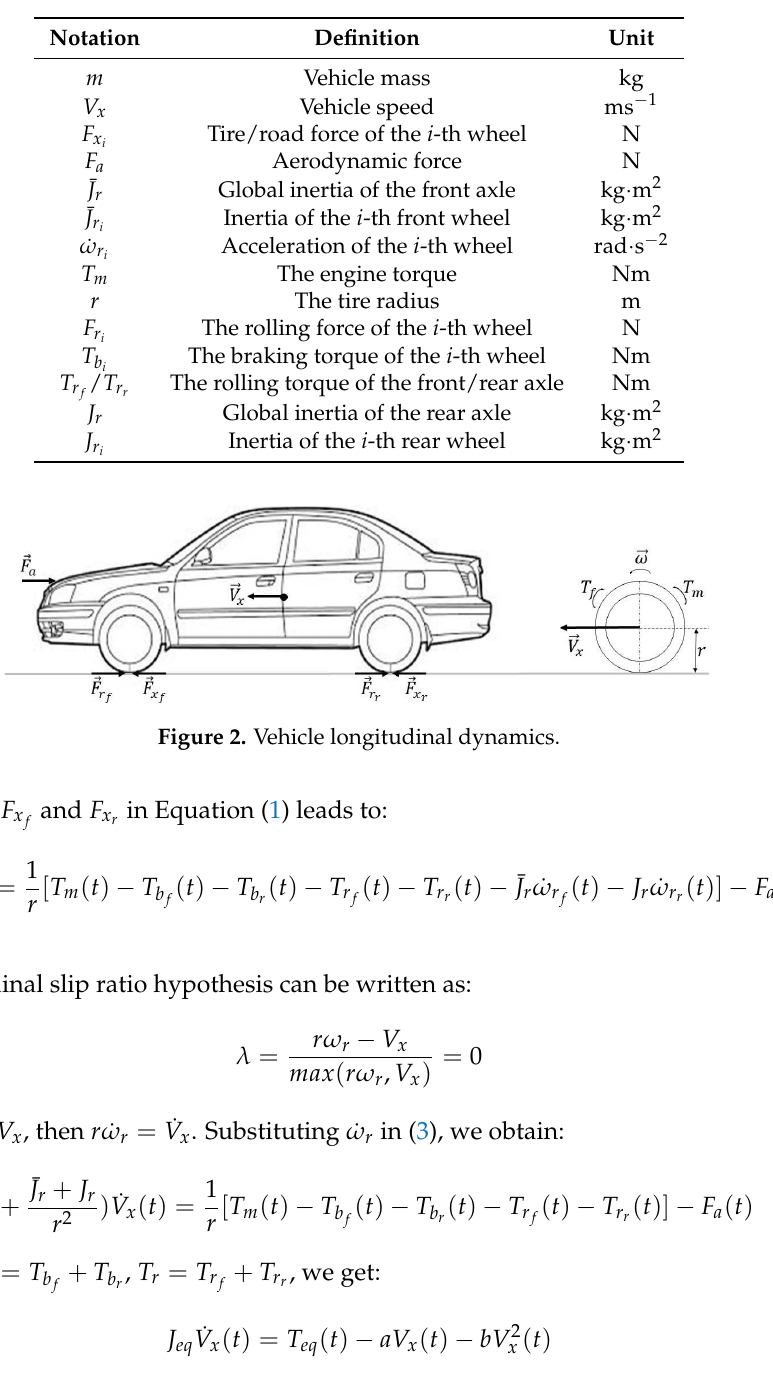
Table 1. Vehicle parameters.